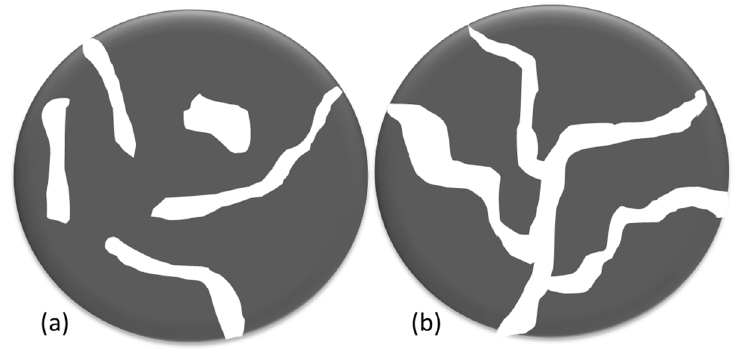
Figure 13. Same porosity, different connectivity. ( a ) closed and dead-end pores (non-connecting); ( b ) network of connected pores.